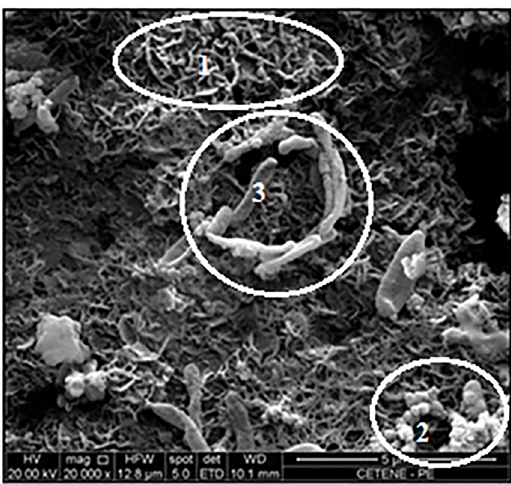
Figure 6. SEM of the specimen exposed in the in the water- containing region, immersed in oil/water system after 60 days; Magnification: 20.000X.